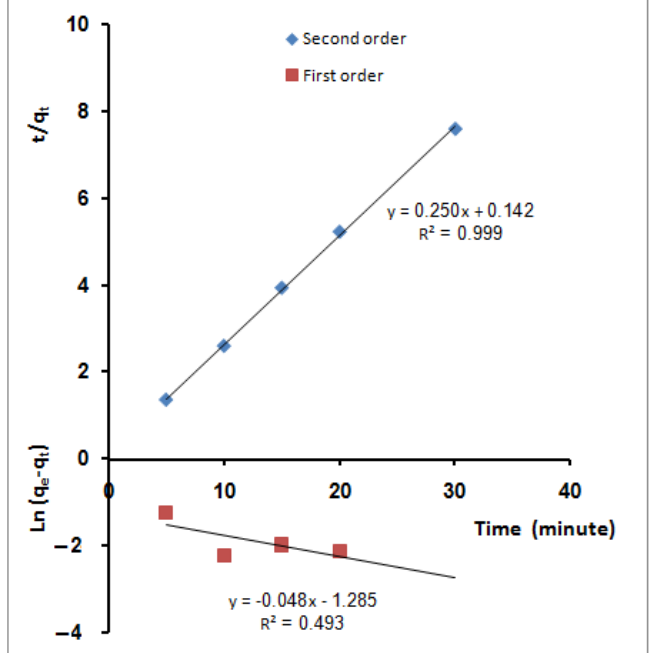
Figure 7. Sorption kinetic models for MB molecules’ adsorption using SPGMA; pseudo-first order and pseudo-second order.